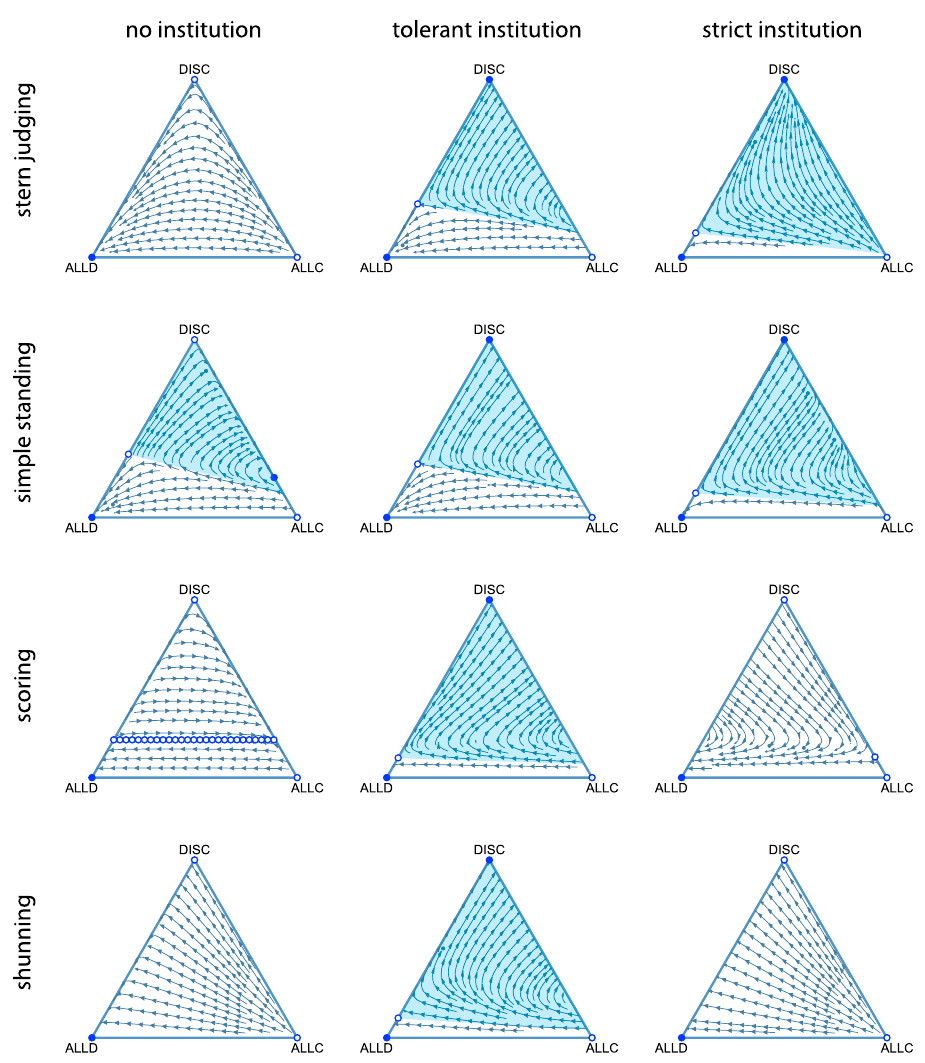
Fig. 2 Public institutions of moral evaluation can facilitate the evolution of cooperation. We analyzed the evolution of behaviors in the donation game for societies with unempathetic private moral assessment (left column) compared to societies with two types of institutionalized moral judgment: tolerant ( q < 1 , middle column) or strict ( q > 1 , right column). The triangular simplex represents the frequencies of three behavioral strategies in an in fi nite 2 2 population: ALLC (always cooperate), ALLD (always defect), and DISC (cooperate with good individuals, defect against bad), for each of four different social norms (rows). Blue arrows indicate the direction of strategic evolution under replicator dynamics, with circles indicating stable ( fi lled) and unstable (empty) equilibria. The basins of attraction towards stable equilibria that support cooperation are highlighted in light blue. Error rates are e 1 = e 2 = 0.02, bene fi ts and costs are b = 5, c = 1, and institution size is Q = 2. Analogous results for e 1 ≪ e 2 , e 1 ≫ e 2 , and b = 10 are shown in Supplementary Figs. 10, 11, and